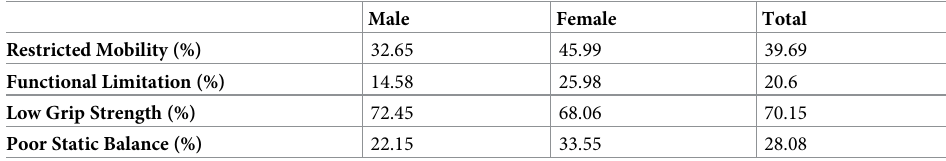
Tables 2 and 3 present the gender differentials in the prevalence of poor subjective and objec- tive health outcomes, by select co-variates. The sex-wise prevalence rates of each of the poor health outcomes have been presented in S1 and S2 Appendices. At the national level, 39.7% and 20.6% of older adults reported restricted mobility and functional limitations, respectively, both of which represent subjective health outcomes. However, a considerably higher propor- tion of older adults were found to have low grip strength (70.2%) and poor static balance (28.1%), when direct health examinations were conducted. The prevalence of restricted mobil- ity, functional limitation, and poor static balance was higher among older women by 13.3, 11.4, and 11.4 percentage points, respectively. However, the rate of poor grip strength was higher among the older men by 4.4 percentage points. By and large, older persons who were the oldest old, widowed, socially disadvantaged, Muslim, living alone, illiterate, currently not working, poorest, rural residents, suffering from multi-morbidities or multiple impairments, having no role in property-related decisions or involvement in other financial matters and in receipt of financial support, reported the highest prevalence rates of poor health outcomes. The gender differences disfavored the older women consistently across all co-variates in the case of both the subjective health outcomes and poor static balance. Table 2. Gender-wise prevalence of poor health